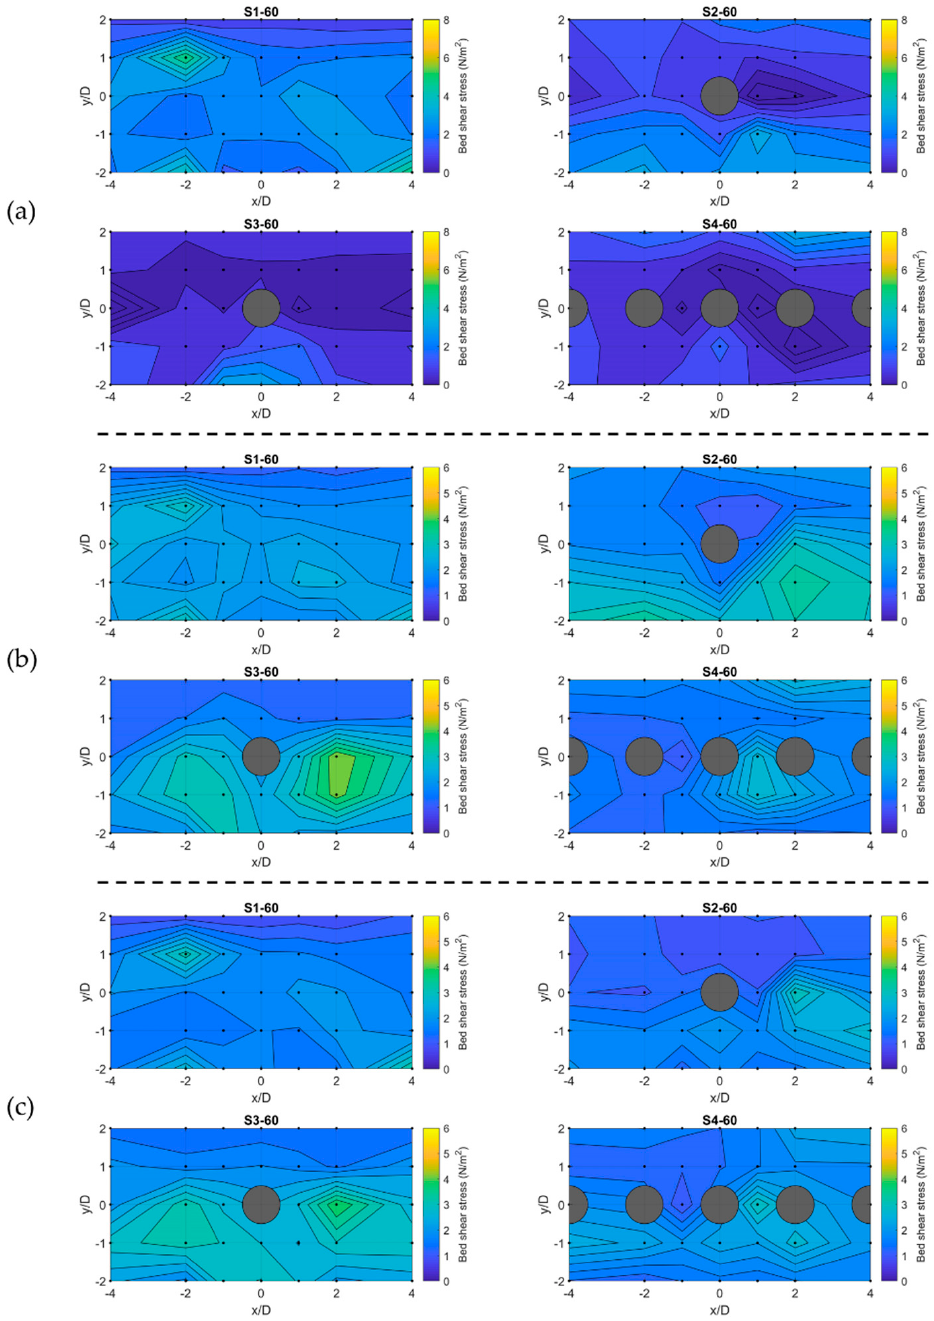
Figure 6. Contour plots of the estimated near-bed shear stress at 60 L / s (unsubmerged condition) for ( a ) the Reynolds, ( b ) TKE, and ( c ) modified TKE methods. Gray circles show the idealized boulders, and small black dots represent the measuring points.